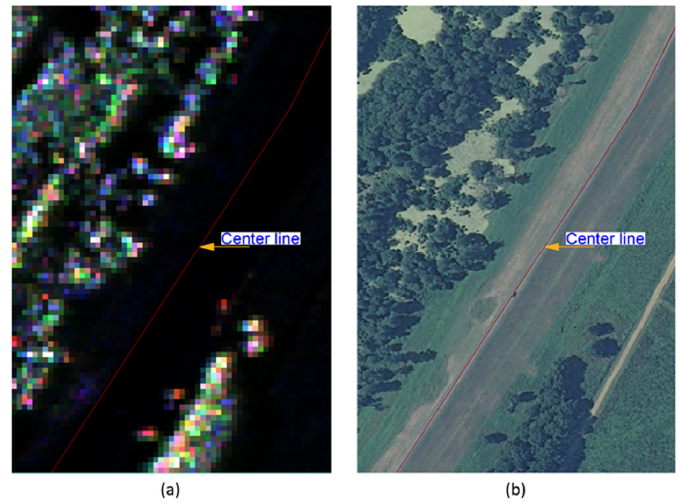
Figure 5. ( a ) Test area SAR image; and ( b ) optical image; overlaid with the levee center line.